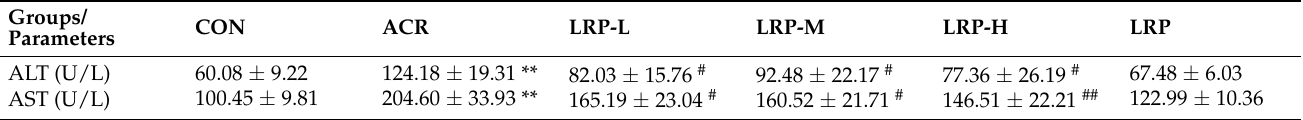
Table 1. Effect of LRP on the ACR-induced serum levels of ALT and AST.